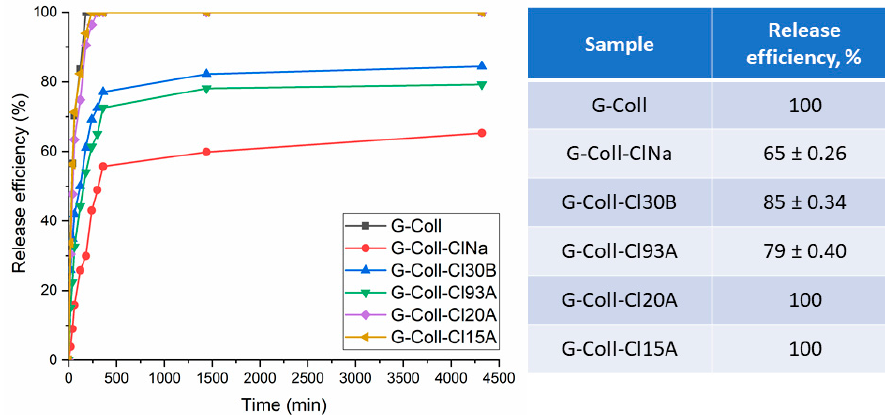
Figure 9. Gentamicin release profile as a function of time.